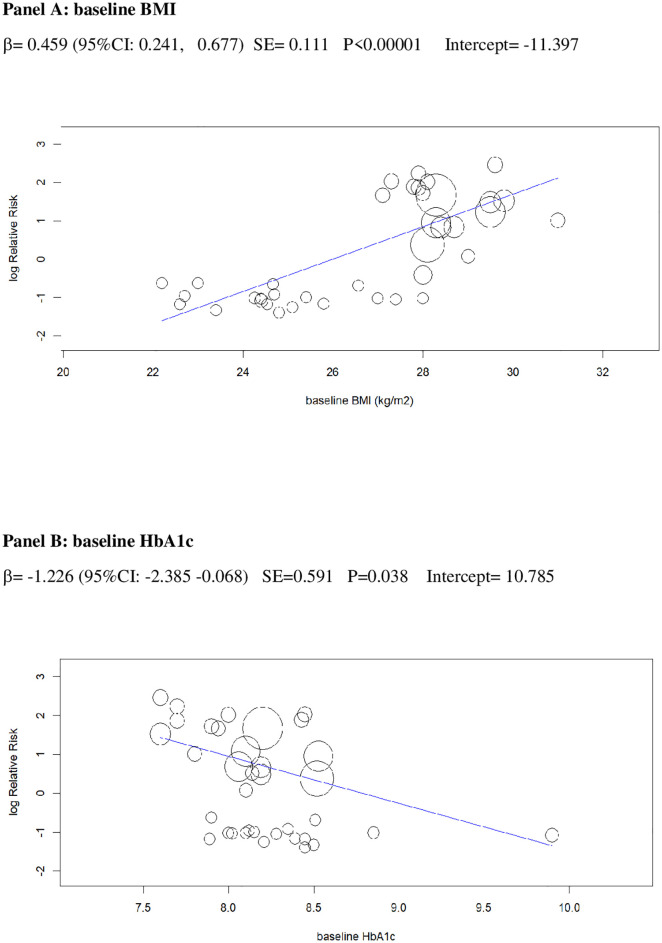
Univariable meta-regression plots for statistically significant moderators of the RR of DKA: Baseline BMI and baseline HbA1c.The radius of the points is proportional to the inverse of the SEs (i.e., larger/more precise studies are shown as larger points). BMI, body mass index; DKA, diabetic ketoacidosis; RR, risk ratio.